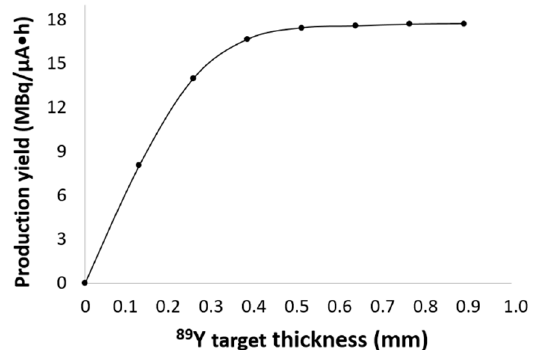
Figure 3. Optimization of production yield using foil targets.